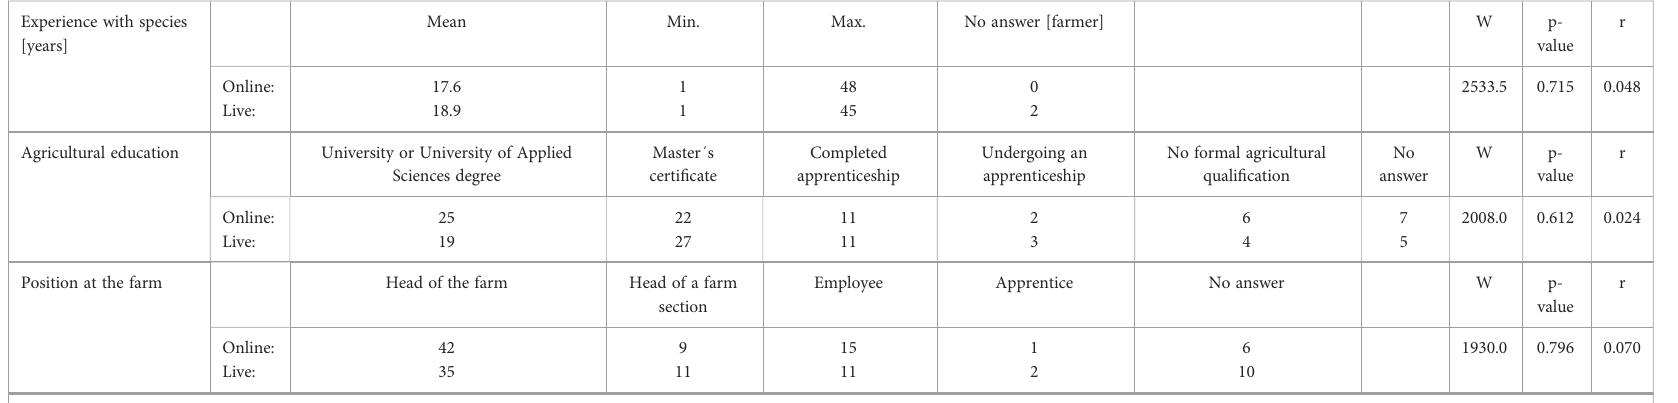
TABLE 3 Comparison of the farmers´ professional background between the online and live trained groups. Experience with species